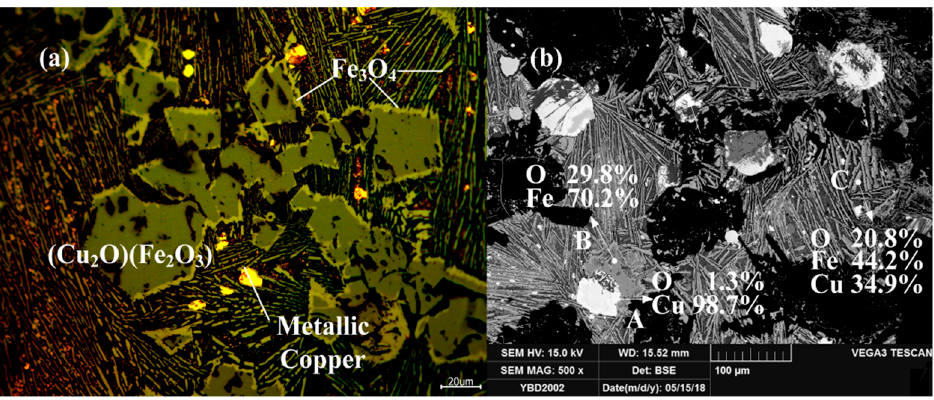
Figure 24. Optical micrograph ( a ) and SEM backscattered electron image ( b ) of YBD18.